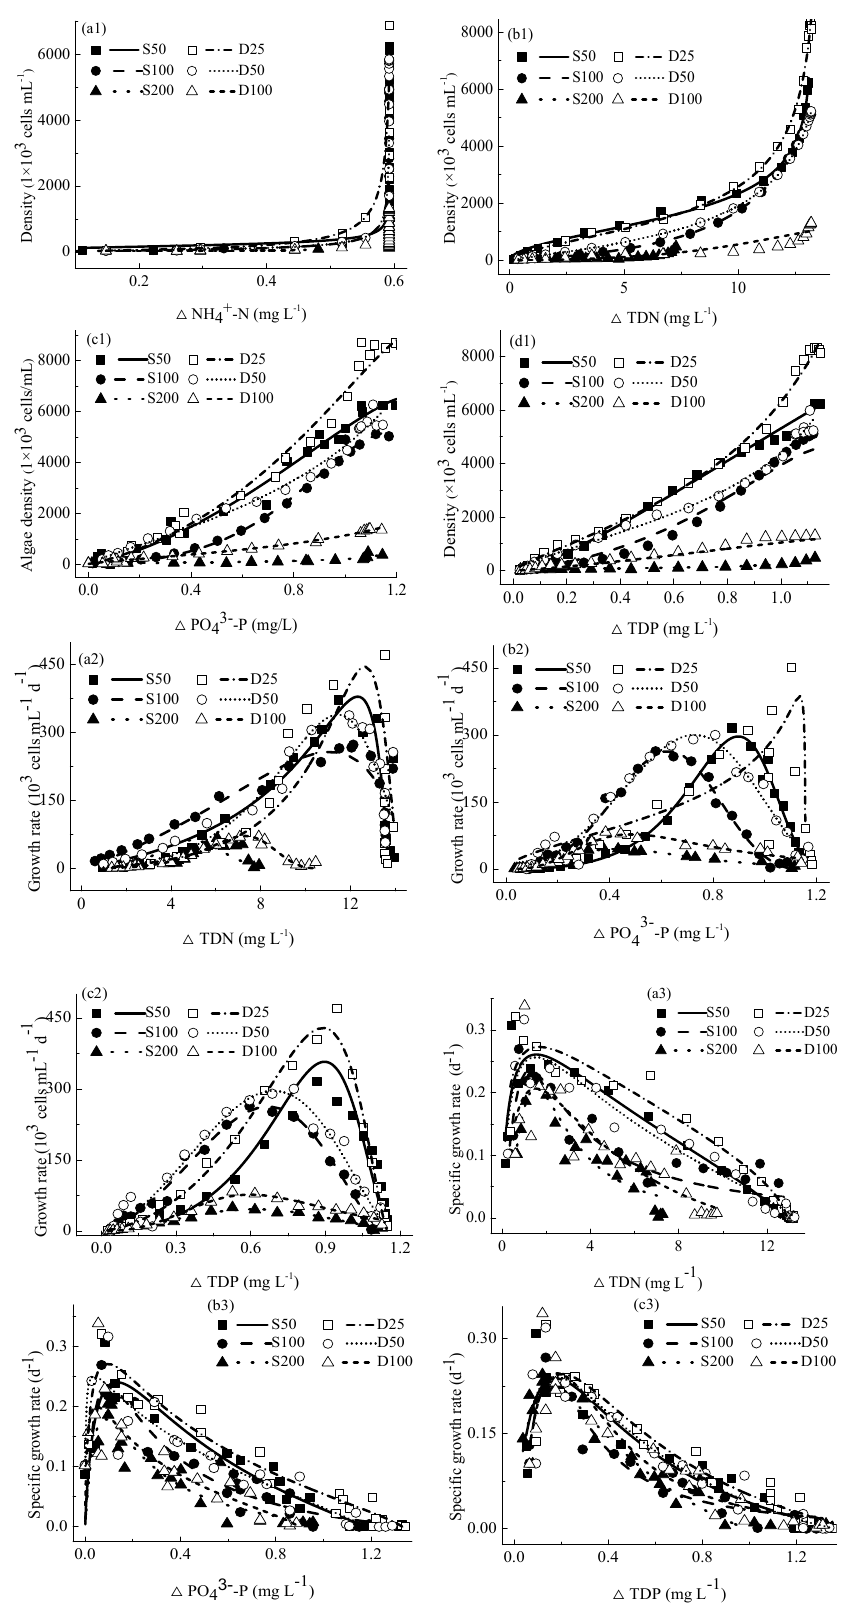
Figure 4. The relationship between M. aeruginosa densities ( a1 – d1 ), growth rate ( a2 – c2 ), specific growth rates ( a3 – c3 ) and concentrations of consumed nutrients . growth rates ( a3 – c3 ) and concentrations of consumed